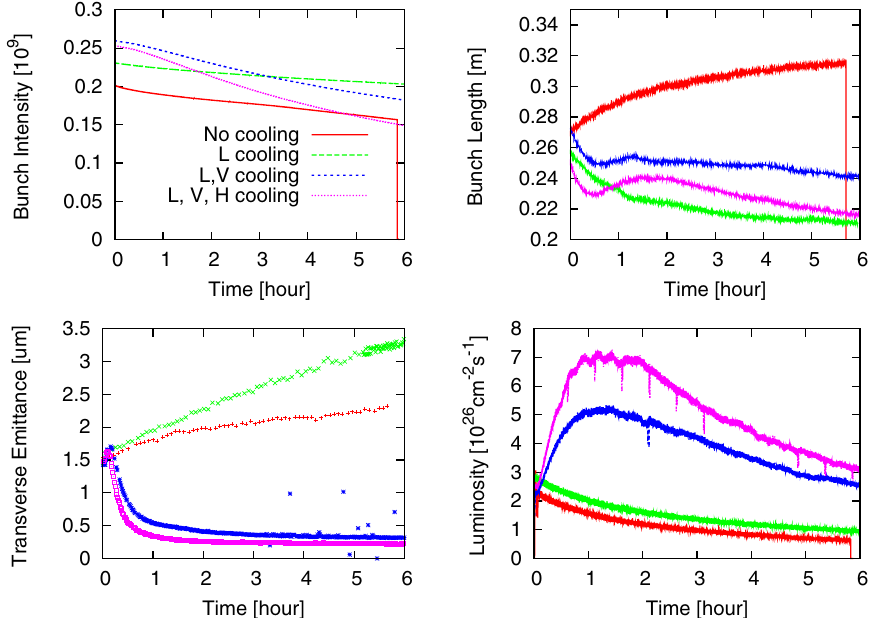
FIG. 9. Comparison of 4 fills without cooling (red), with longitudinal cooling (green), with longitudinal and vertical cooling (blue), and with 3-d cooling (pink) in the 2012 96.4 GeV U-U run. Top left: averaged bunch intensity. Top right: rms bunch length of the central bunch. Bottom left: rms transverse emittance. Bottom right: luminosity measured at IP8 with